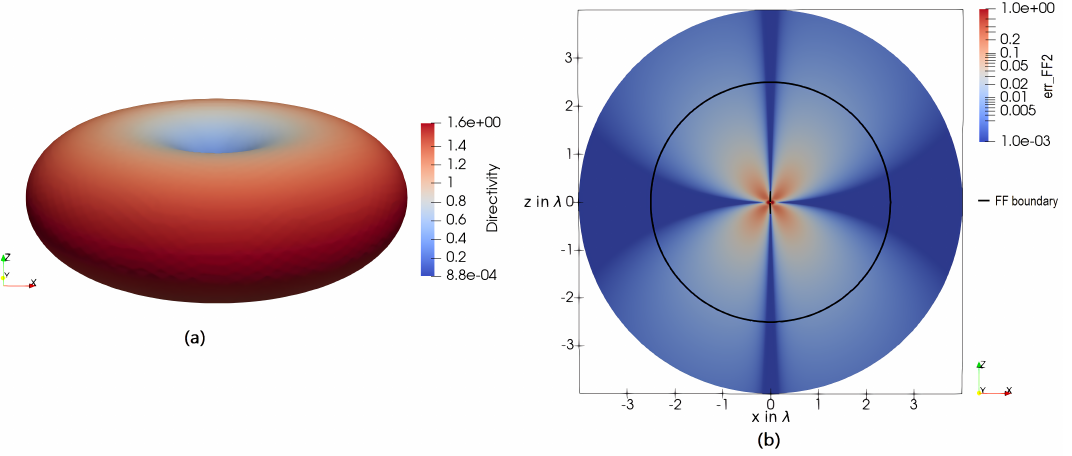
Figure 9. ( a ) A 3D plot of the directivity D ( θ , φ ) of a 0.5 λ dipole. ( b ) The error-estimator 6, describing a qualitative measure of the FF quality, applied on a 0.5 λ dipole in the E-plane. The FF boundary r far for the given antenna dimension l = 0.5 λ given in 4 is displayed as a black